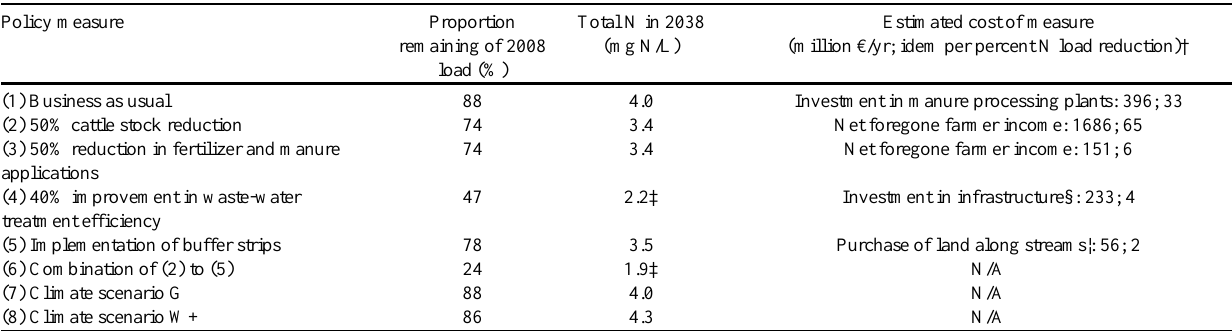
Table 4. Effects of implemented policy measures, as estimated using the PCRaster-Extend model suite in terms of load reduction at Hemiksem in 2038 and distance to water quality target as indicated by the mean summer concentration, which can be compared with the EU Water Framework Directive nitrogen standard for good ecological condition of 2.5 mg nitrogen/L for large rivers in Flanders. Investment cost is annualized measured at a 4% interest rate over 20 yr applying 2010 € values. Nitrogen concentration for the business-as-usual scenario is lower than in Fig. 6 because the 2008 values are lower than those for 2006.